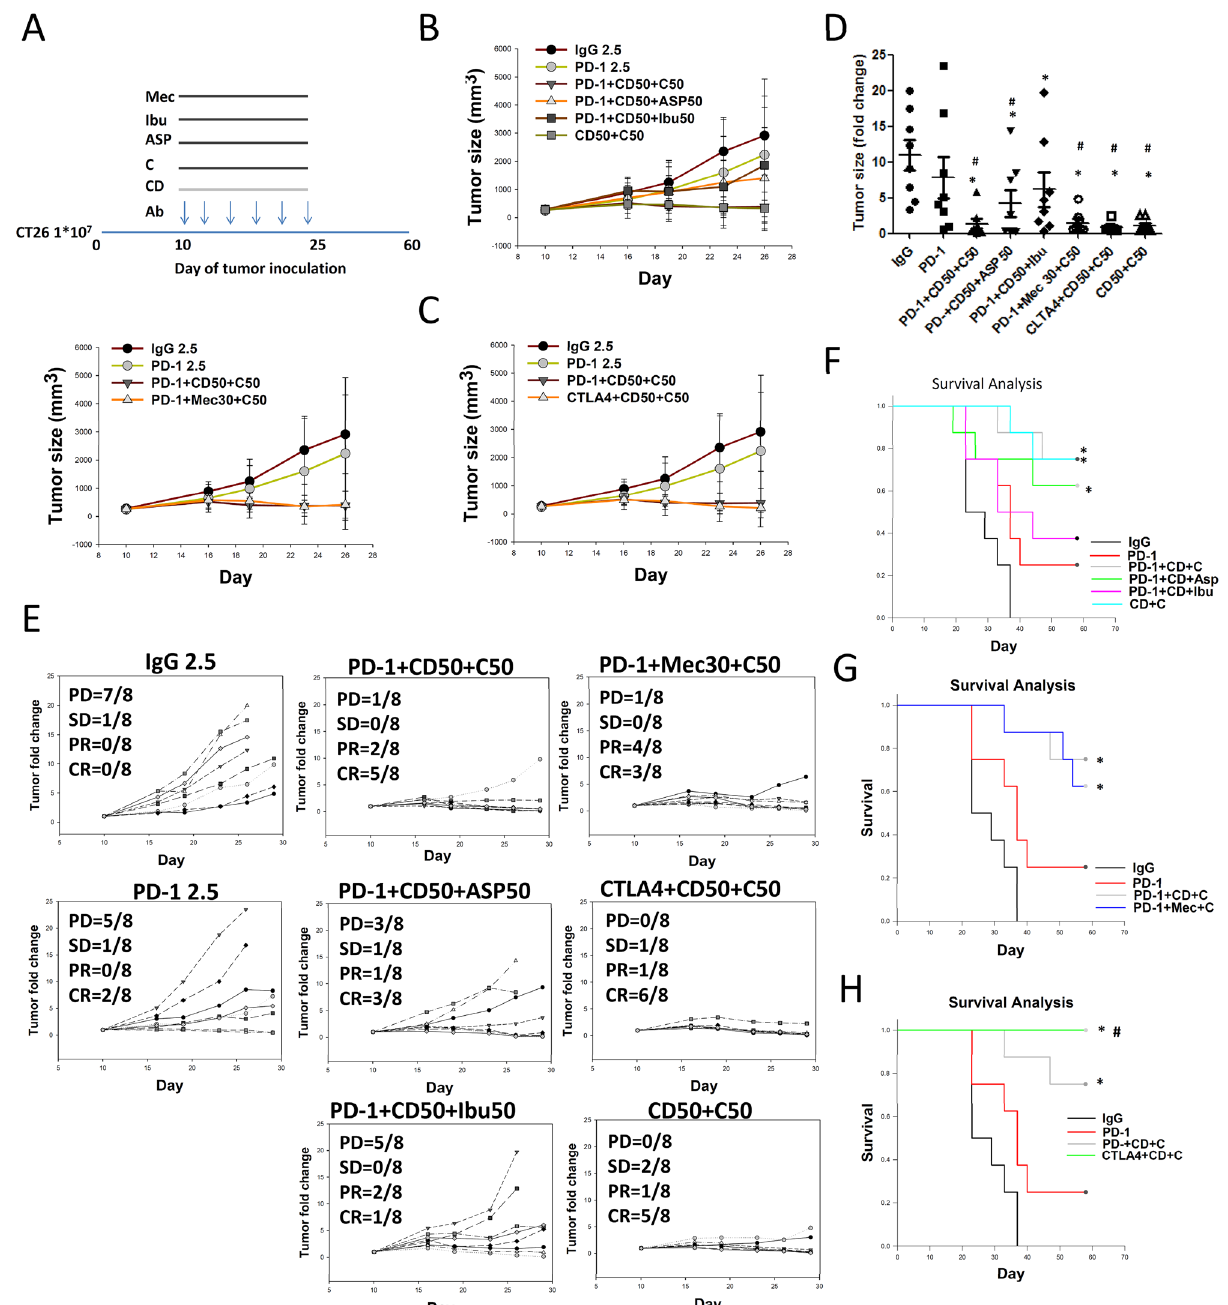
Figure 4. Class I HDAC inhibitors (HDACi) + COX inhibitors (COXis) enhance anti-PD-1-induced immunotherapy in an allograft CT26 mouse model. ( A–C ) CT26 tumor-bearing mice were administered class I HDACi (chidamide-k30 or mocetinostat) once daily (50 mg/kg) from days 10 to 25 (Day 10 mean tumor volume (TV), 223 ± 36 mm 3 ), and COXis (celecoxib, aspirin, and ibuprofen) (50 mg/kg) once daily from days 10 to 25. Arrows indicate the time points at which mice were treated with immune checkpoint inhibitors (ICIs; anti-PD-1 and anti-CTLA4 antibody). The mice were treated with anti-PD-1 antibody (2.5 mg/kg, i.p.) once every 3 days on days 10, 13, 16, 19, 22, and 25. ( D ) Endpoint tumor size is presented as fold change. Results are shown as mean ± standard deviation (SD). *p < 0.05 vs. anti-IgG; # p < 0.05 vs. anti-PD-1. ( E ) Individual tumor growth graphs for CT26 tumor-bearing mice (n = 8). Number of tumor-free mice per total number of mice is shown at the top left corner of each panel. ( F–H ) Survival study after treatment with class I HDACi + COXi + ICI combination